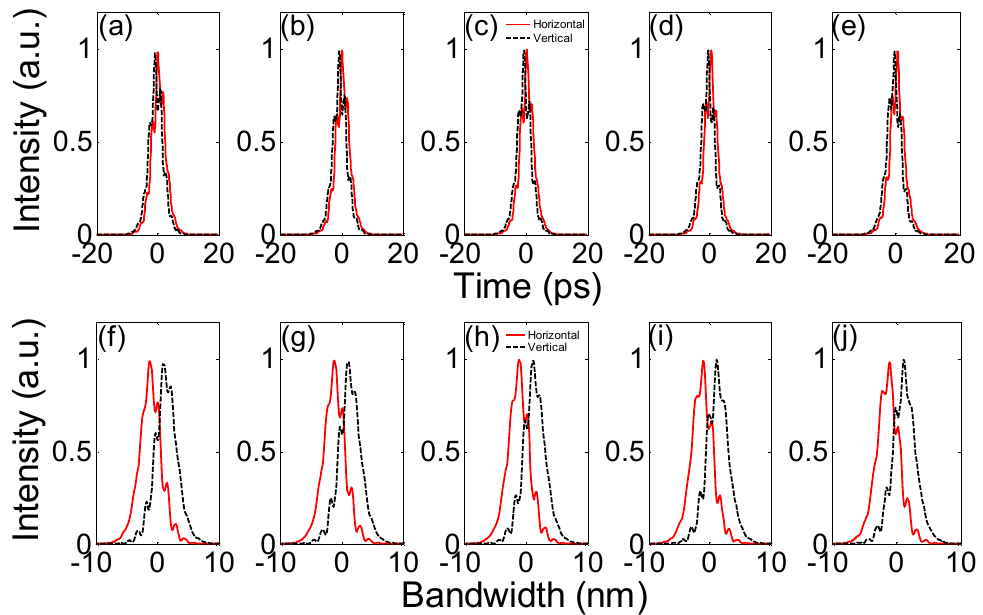
Figure 11. Theoretical results after polarization splitting when the phase difference is changed and λ 1 = λ 2 = 1064 nm.